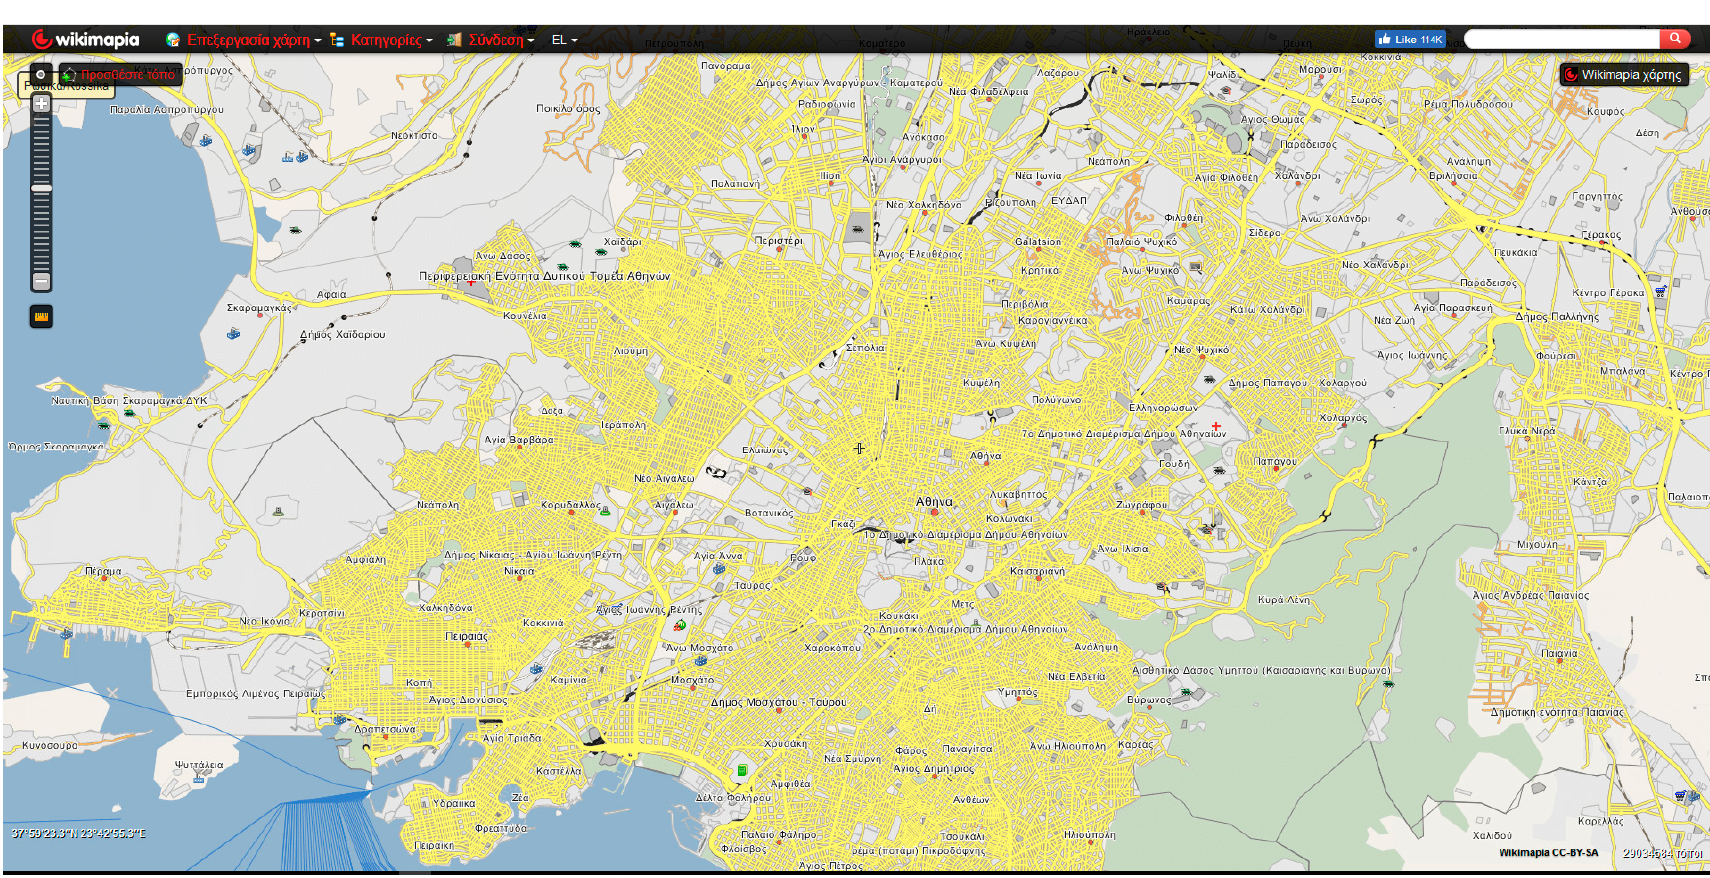
Figure A4. Wikimapia maps (http://wikimapia.org/#lang=el&lat=37.988993&lon=23.715363&z=13&m=w).